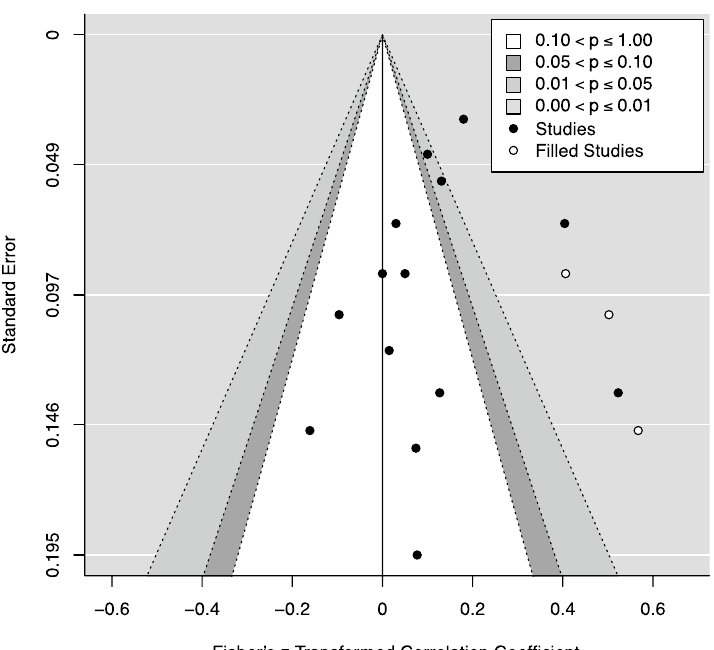
Figure 4. Contour-enhanced funnel plot for studies for which within-couple correlations for autistic traits measures could be determined. Black circles represent individual studies; white circles represent the hypothesised missing studies imputed via the trim and fill